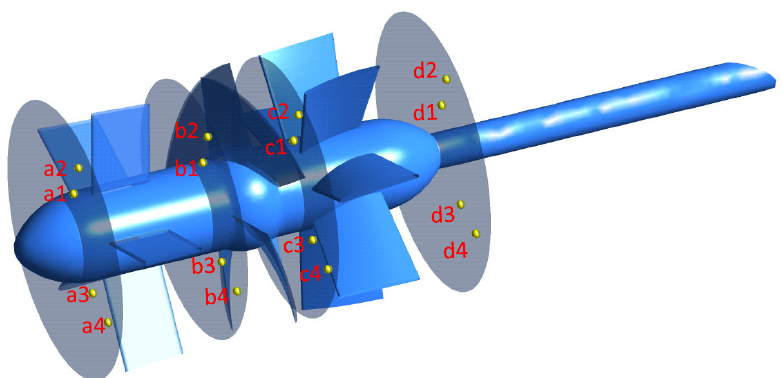
Figure 4. Monitoring point setting.